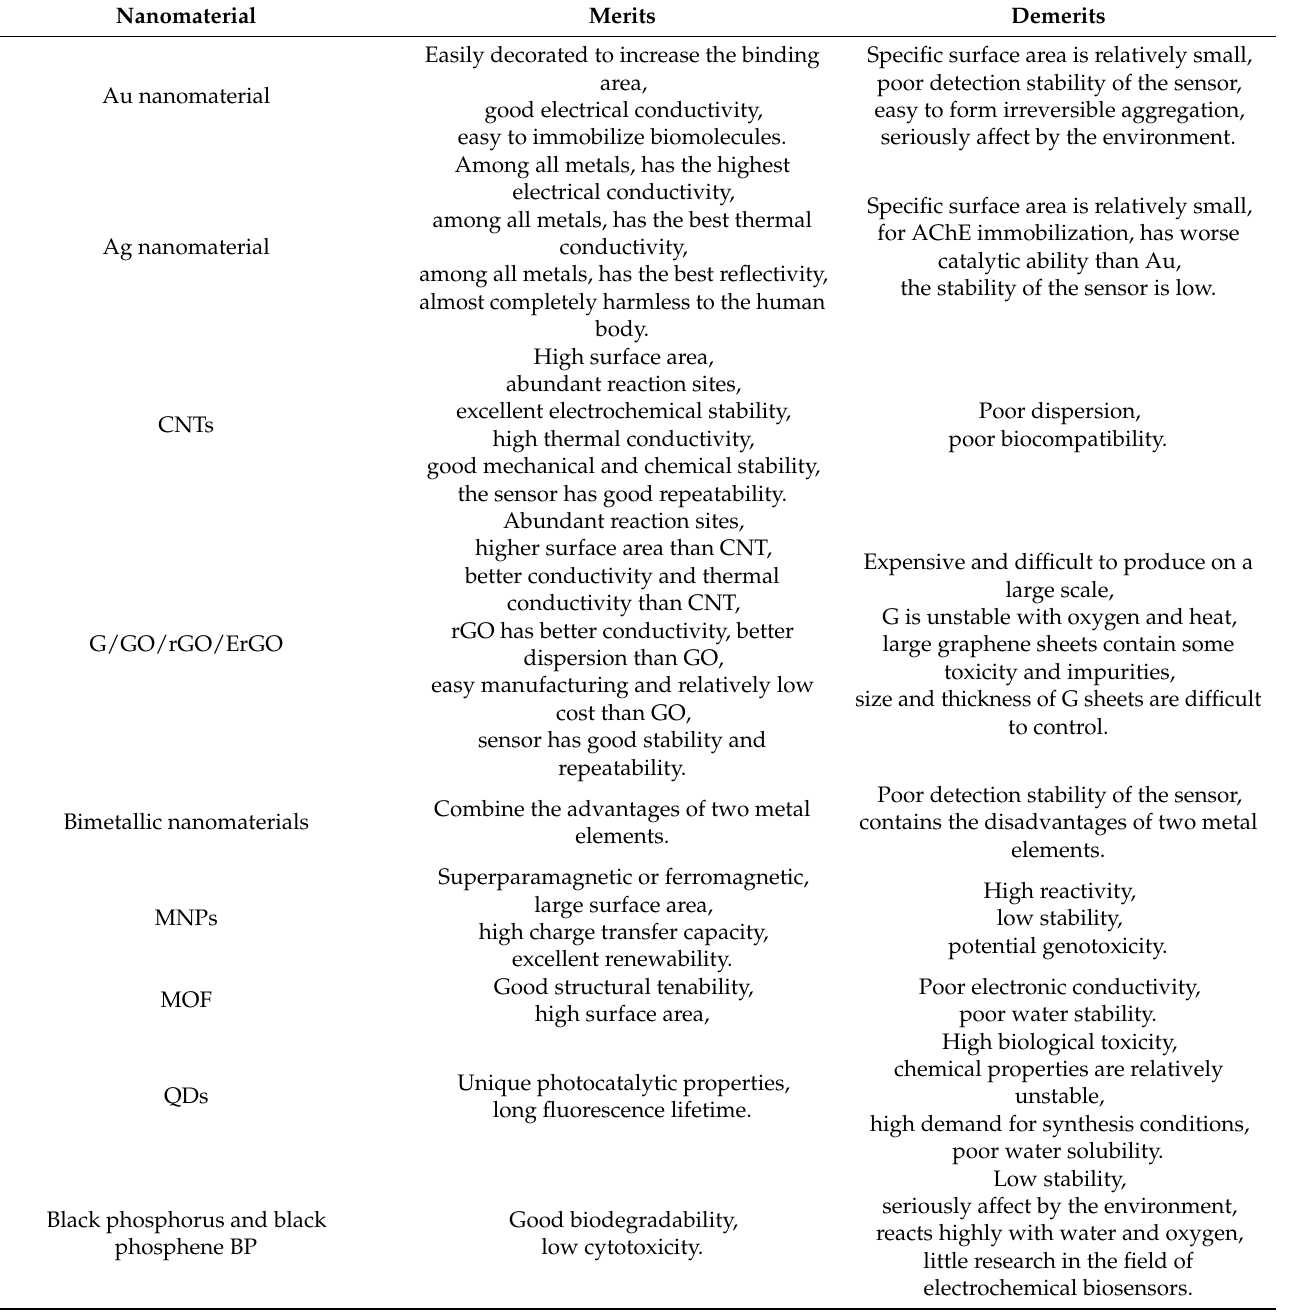
Table 9. Merits and demerits of major nanomaterial-based electrochemical biosensors for detecting pesticides and